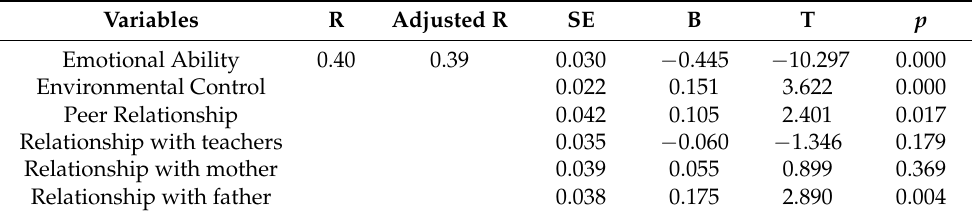
Table 11. Model summary of hierarchical regression analysis that predicts school success.